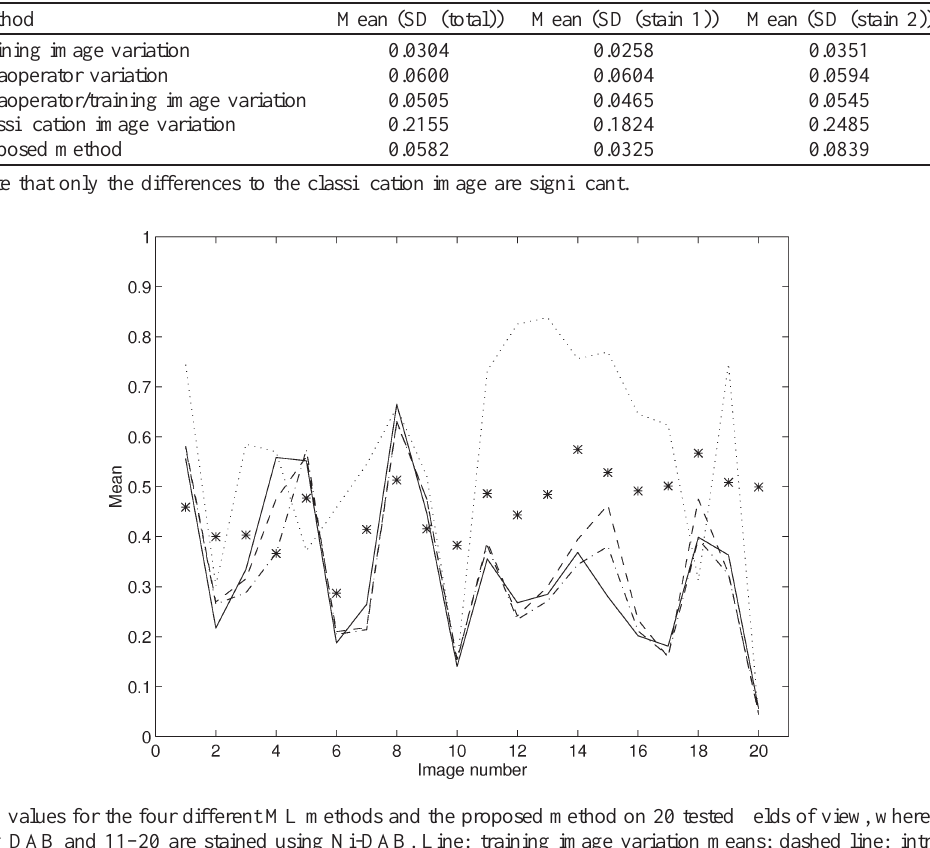
Table 1 Average standard deviations for the four ML methods and the proposed method